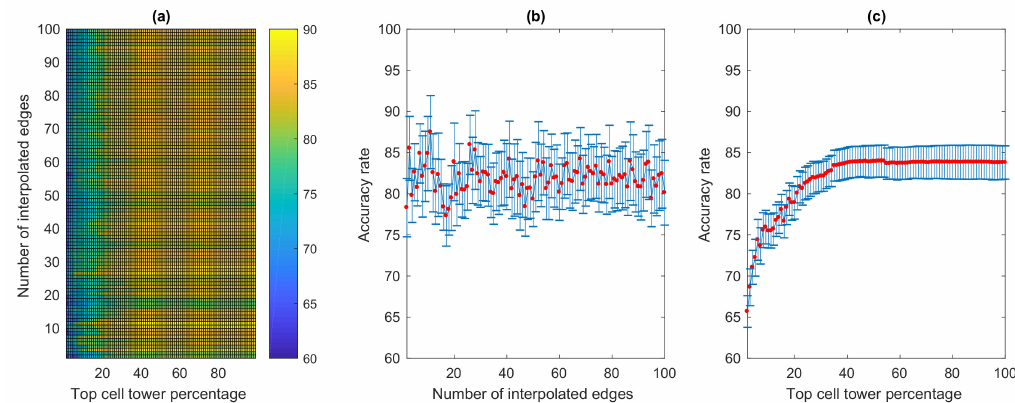
Figure 18. Results based on the interpolation-based method implemented with DBSCAN-based noise filtering: ( a ) accuracy rates; ( b ) average and standard deviation of the accuracy rates of varying numbers of interpolated edges; ( c ) average and standard deviation of the accuracy rates of varying numbers of top cell tower percentage.